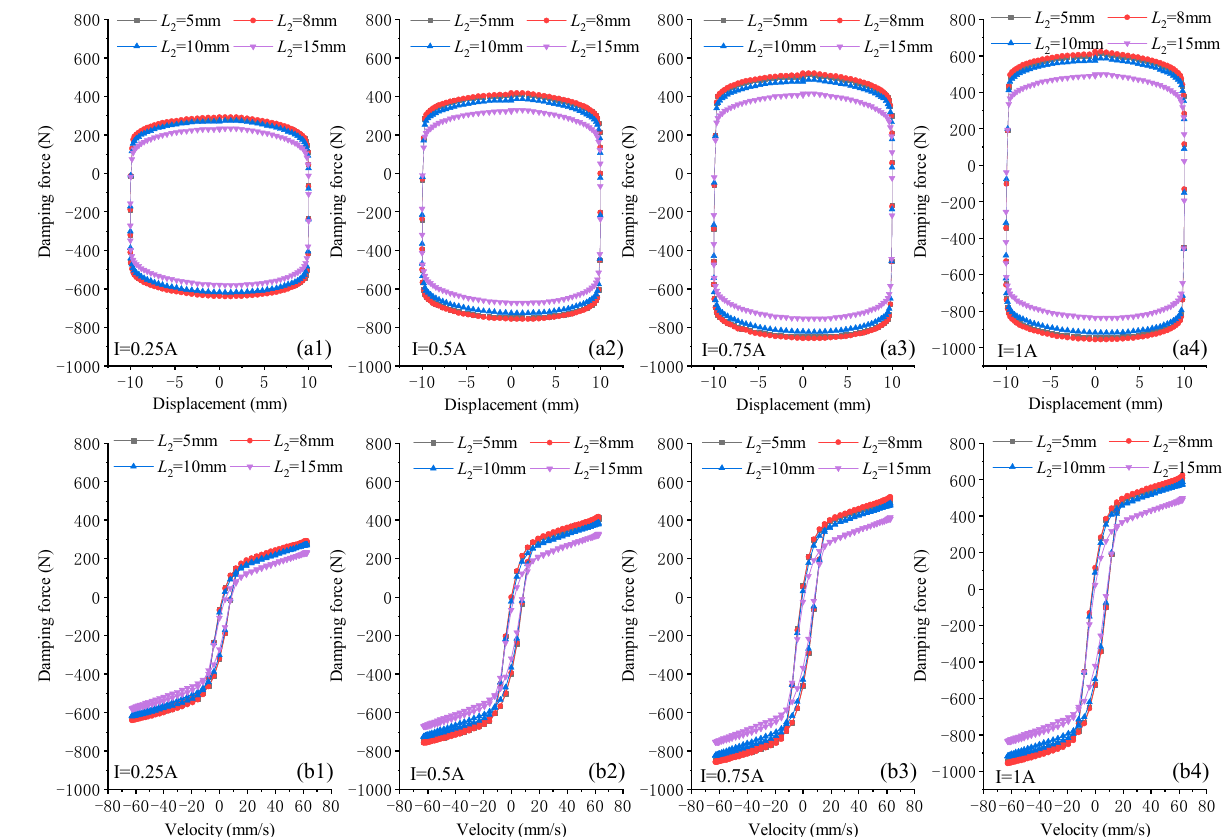
Figure 13. Damping characteristics of effective magnetic poles in the middle for I = 0.25, 0.5, 0.75 and 1 A: ( a1 – a4 ) damping force–displacement; and ( b1 – b4 ) damping force–velocity.